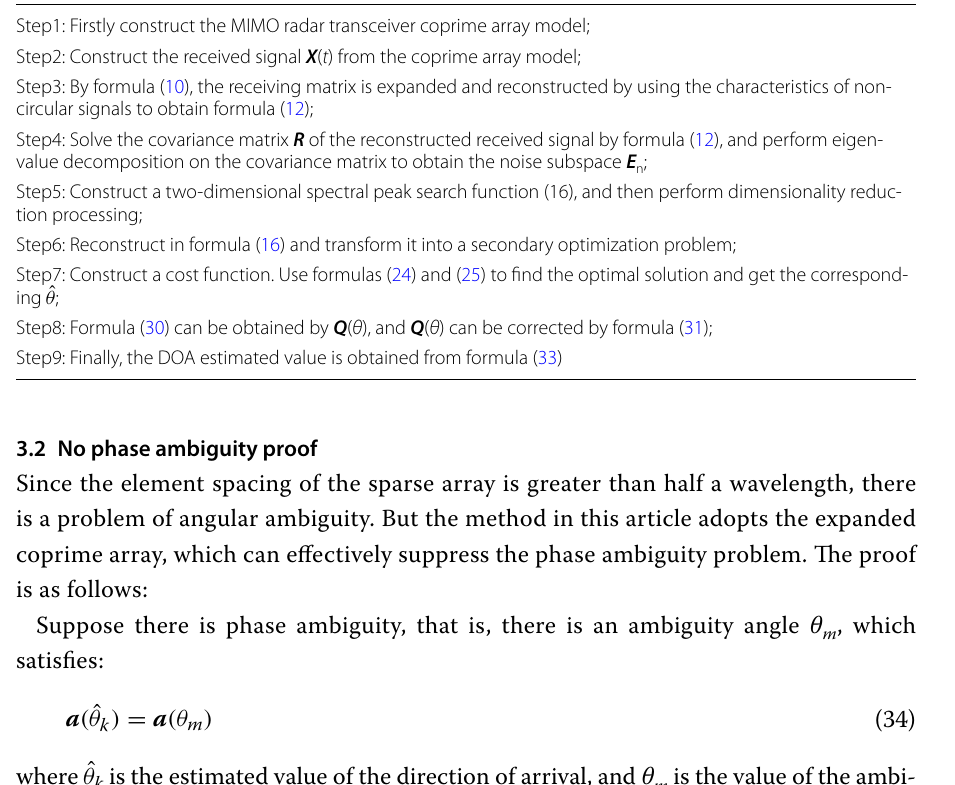
Table 1 The method steps of this